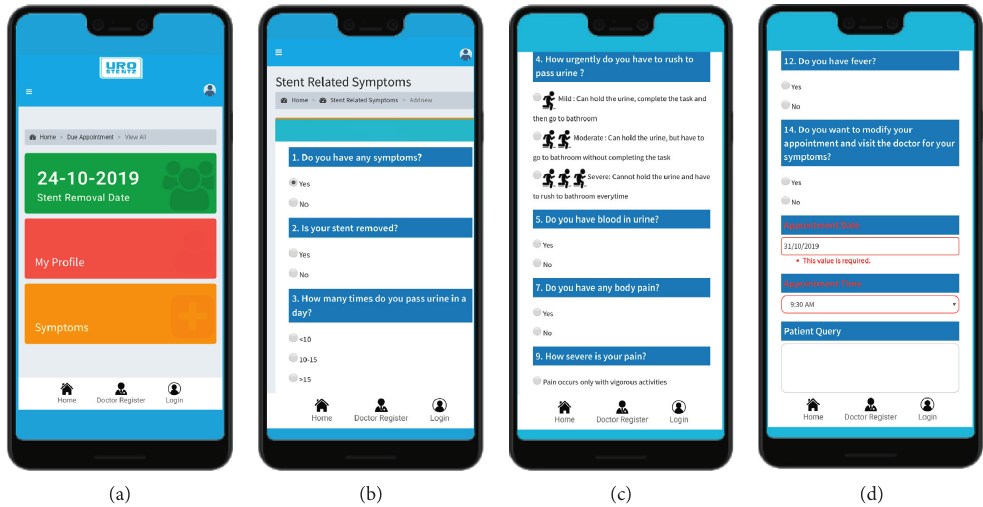
Figure 2: (a) Patient dashboard showing the scheduled date of stent removal, access to symptom questionnaire, and personal profile. (b–d) Pictorial symptom questionnaire for patients with stent-related symptoms and symptoms even after stent removal (reproduced with the permission of developers of the application (RAYZ